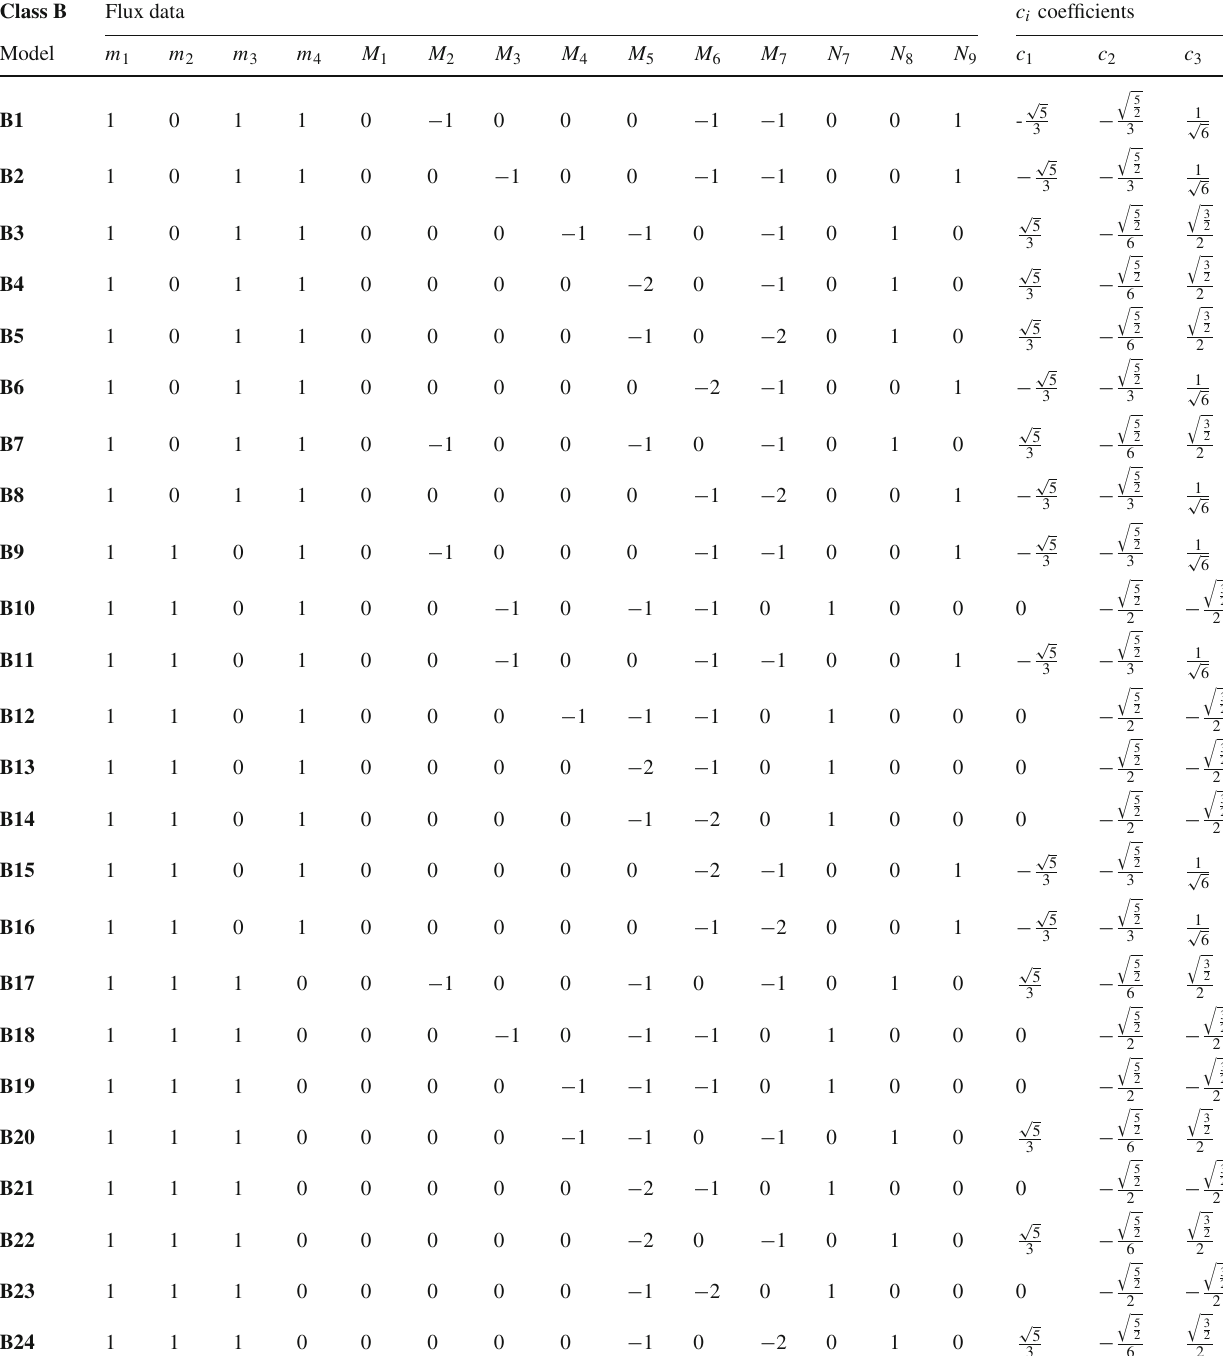
Table 10 Class B models, flux data and the corresponding c i